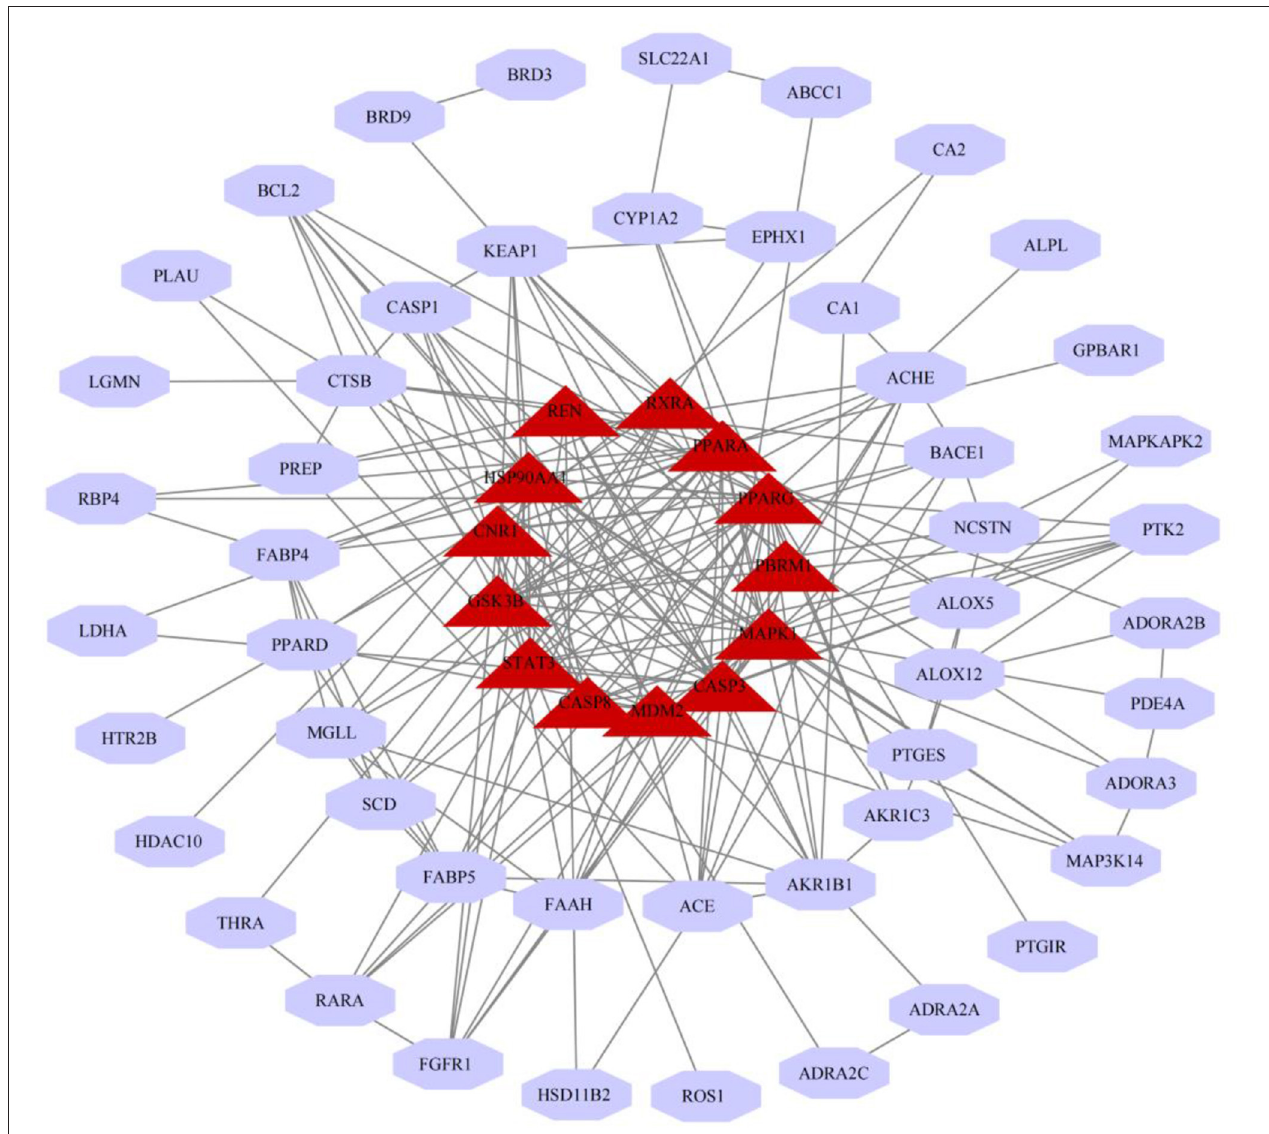
FIGURE 5 | Topological analysis of PPI network. Red nodes on the inner circle indicate hub